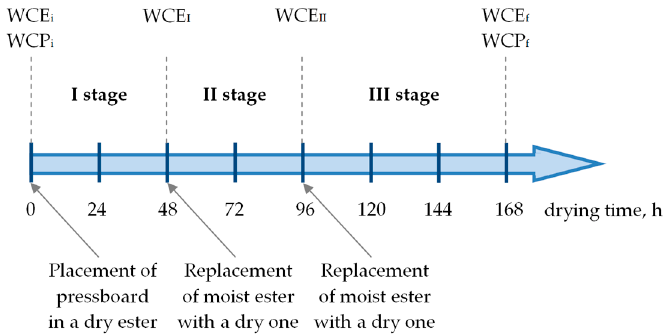
Figure 3. Drying procedure; WCE—water content in ester; WCP—water content in pressboard.